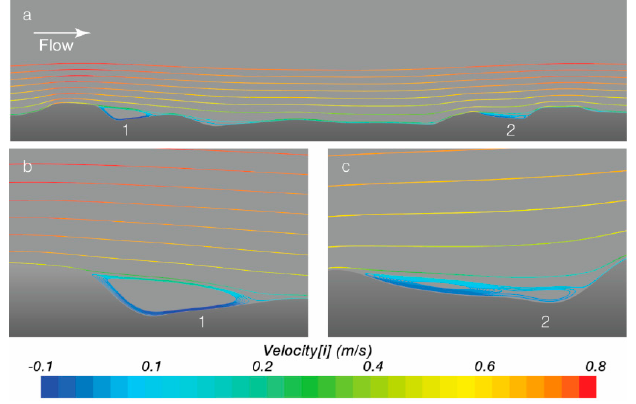
Figure 10. ( a ) Streamline plot of valley section one where ‘1’ and ‘2’ correspond to the depression on the valley floor for the upstream and downstream valleys, respectively; ( b,c ) Enlarged view of the depressions 1 and 2, respectively.